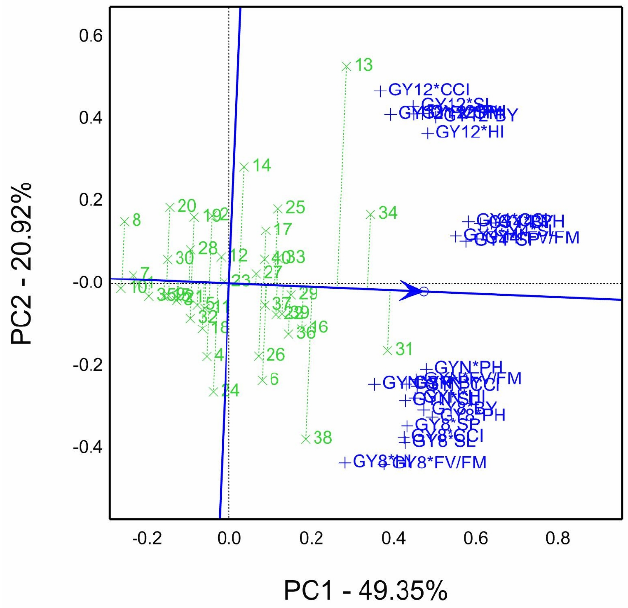
Figure 5. Means vs stability biplot (ranking) of forty wheat genotypes grain yield gm per pot (GY) grown under 0.4, 4.0, 8.0, and 12.0 dS/m diluted seawater evaluated in pot experiments in the 2019/20